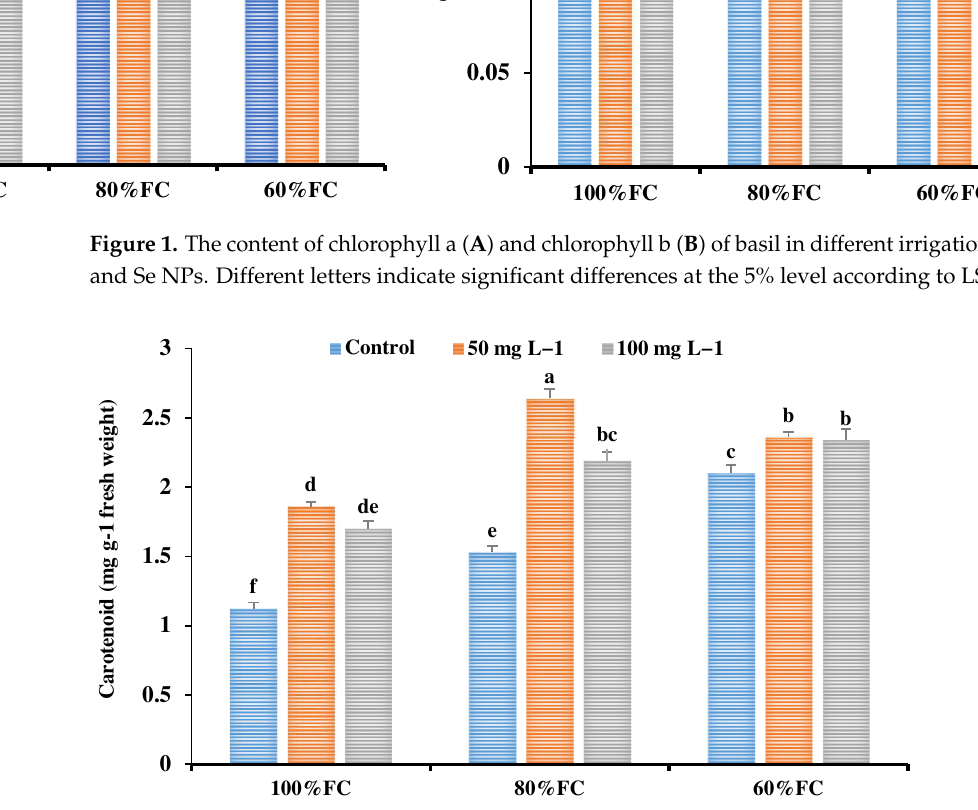
Figure 2. The content of the carotenoid of basil in different irrigation regimes and Se NPs. Different letters indicate significant differences at the 5% level according to LSD’s test.